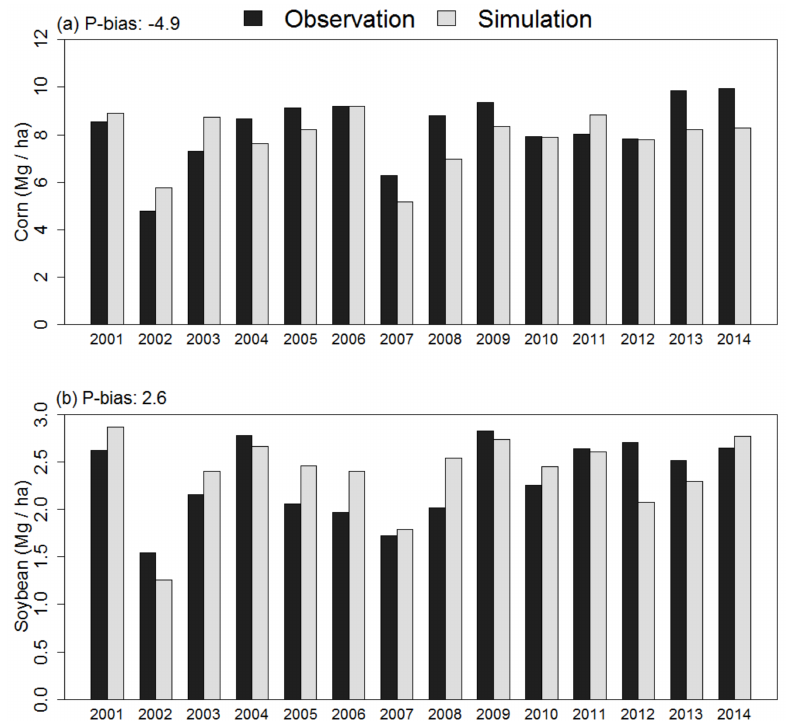
Figure 3. Comparison of observed and simulated ( a ) corn and ( b ) soybean yields under the baseline period.